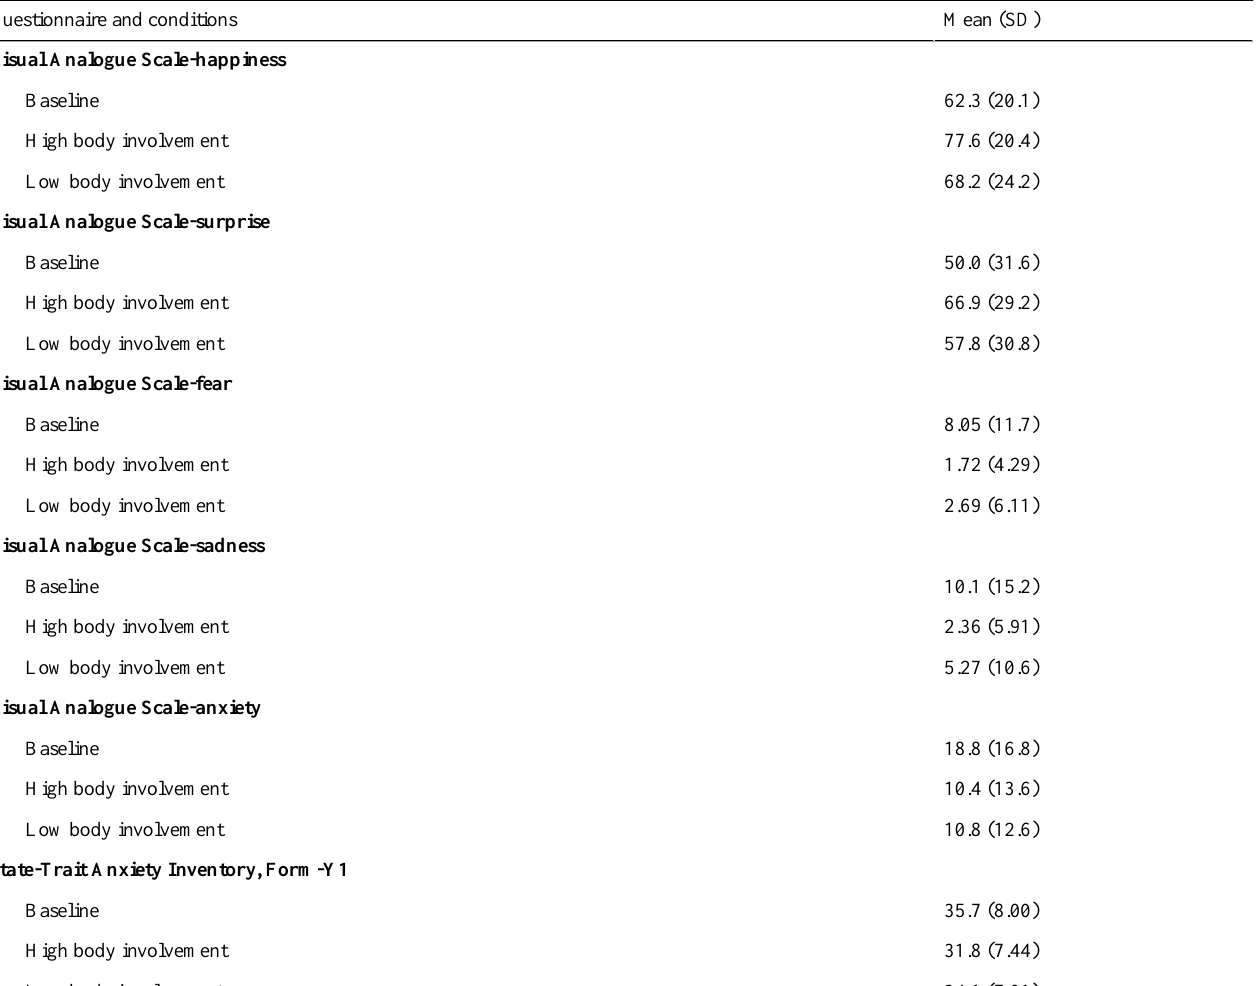
Table 2. Self-reported emotions and anxiety scores among subjects in the experimental